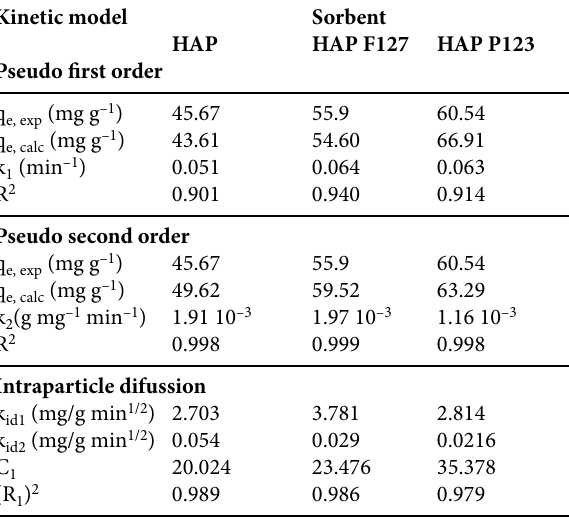
Table 4. Kinetic parameters of the adsorption of Al(III) ions.